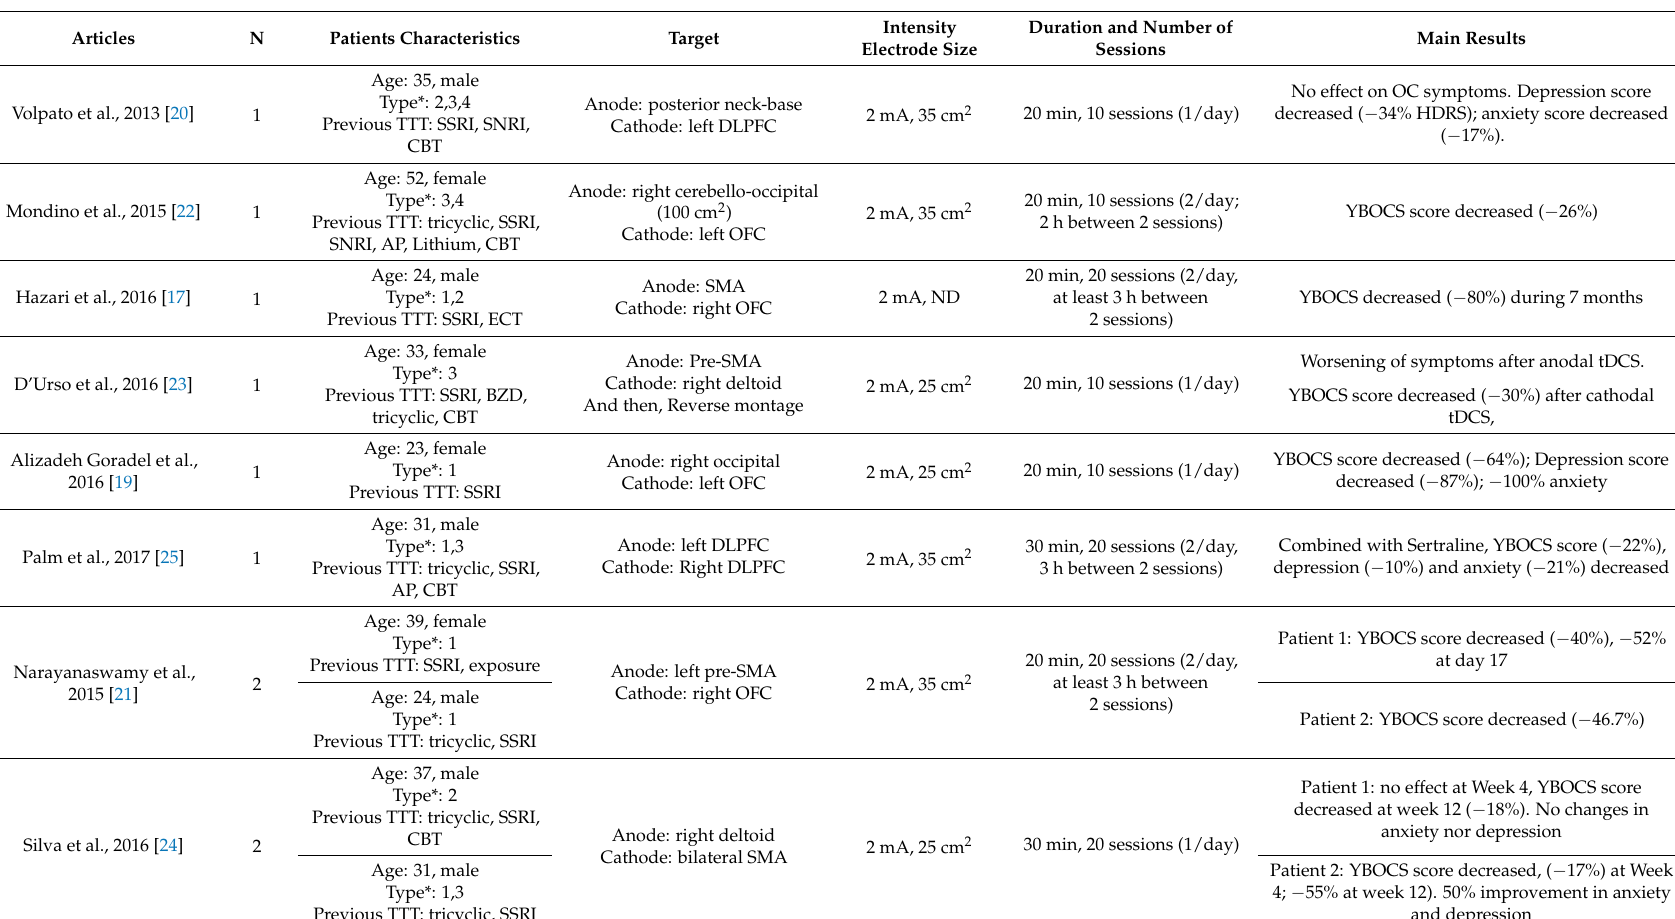
Table 1. Main findings of studies investigating the clinical interest of transcranial direct current stimulation (tDCS) to decrease symptoms in patients with obsessive-compulsive disorder